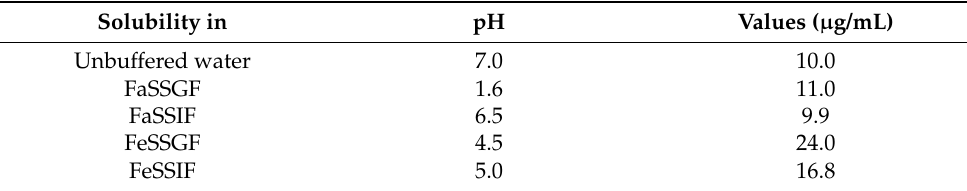
Table 2. Solubility of Riva in biorelevant